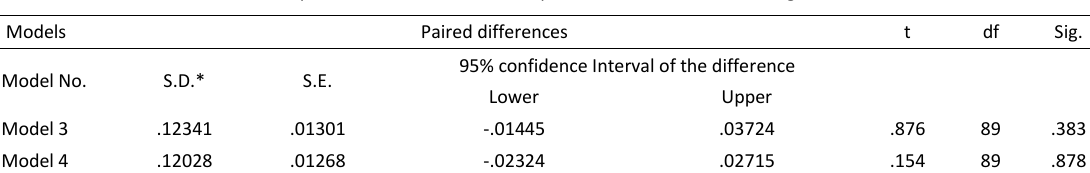
Table 8: Comparisons of the observed and predicted value of solid waste generation rate Models Paired differences df